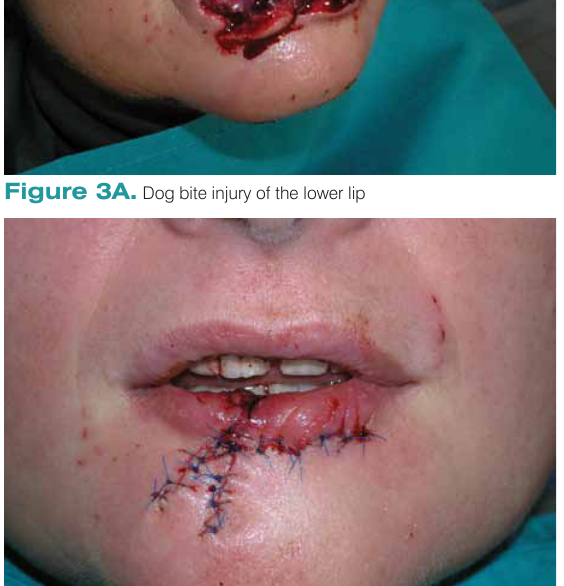
Figure 3B. Immediately after surgical treatment